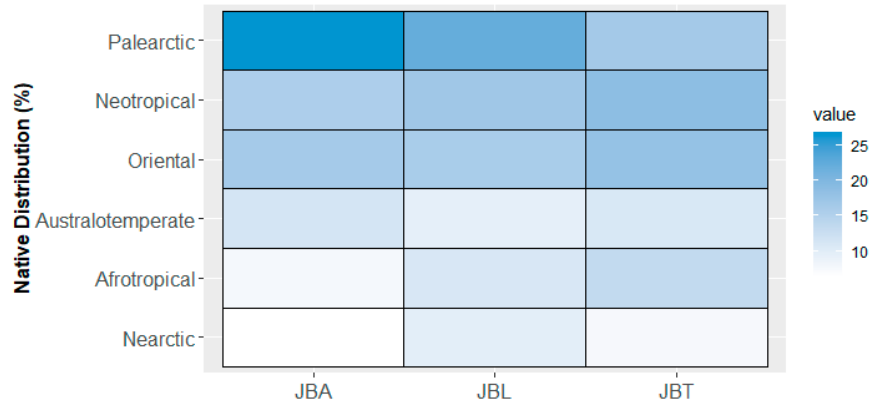
Figure 5. Heatmap showing the biogeographic distribution of taxa found in each Botanical Garden of Lisbon (JBA, JBL, and JBT). Color intensity indicates the relative proportion of the taxa from the six most represented biogeographic origins.